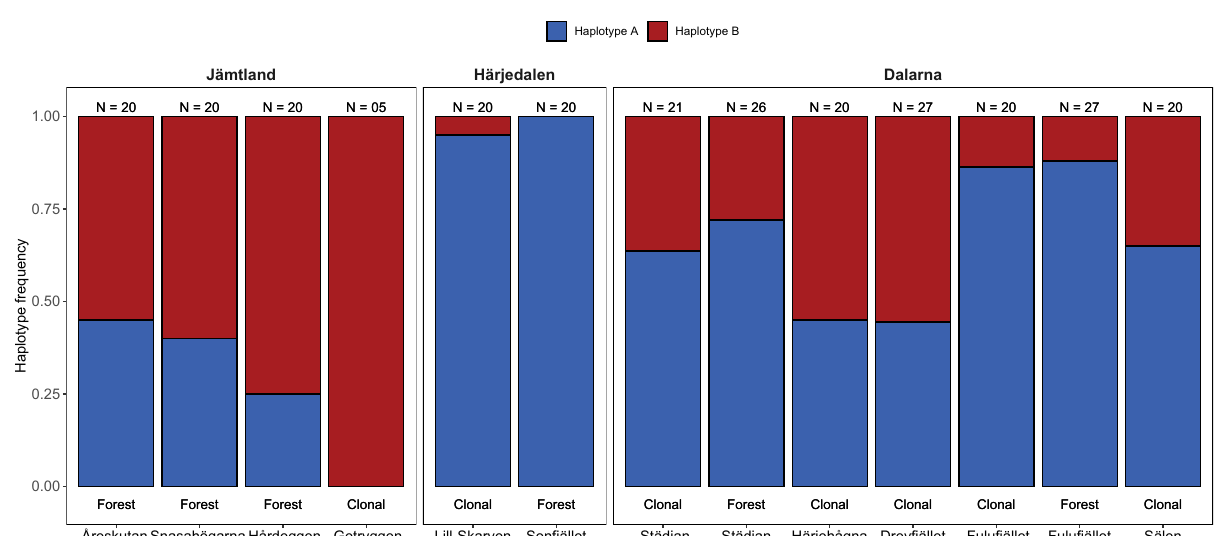
Fig. 4 Mitochondrial mh05 haplotype frequencies (y-axis, proportion of individuals with either haplotype A or B within a population) in clonal and forest spruce populations ordered by latitude (x-axis). Haplotype A (blue) is less abundant in populations from Jämtland County in the north and almost fi xed in populations further south in Härjedalen County. The most southern populations from Dalarna County show a generally higher frequency of haplotype A. Clonal and surrounding forest populations shows almost identical haplotype frequencies. Population Getryggen consists of only fi ve trees, the rest of the populations included between 20 and 27 trees as indicated for each population above the bars ( N = ). For each bar it is indicated whether a population was clonal or forest. Source data are provided in the Source Data fi